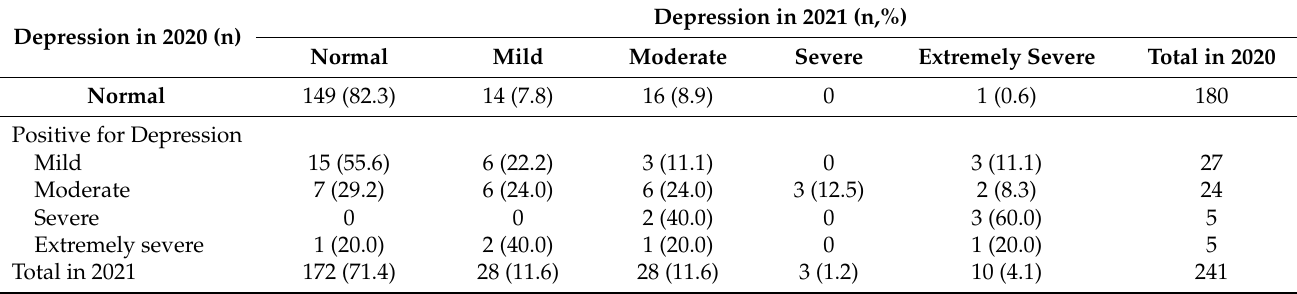
Table 2. Longitudinal changes of depression and anxiety by severity in June 2020 and June